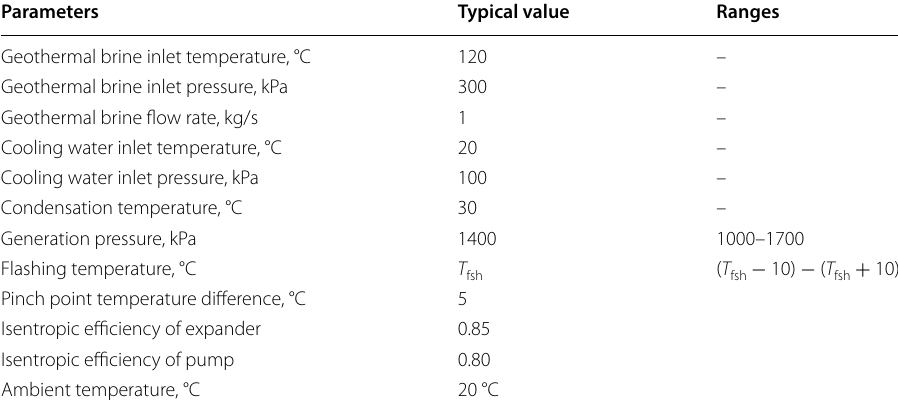
Table 2 Operating conditions and parameters